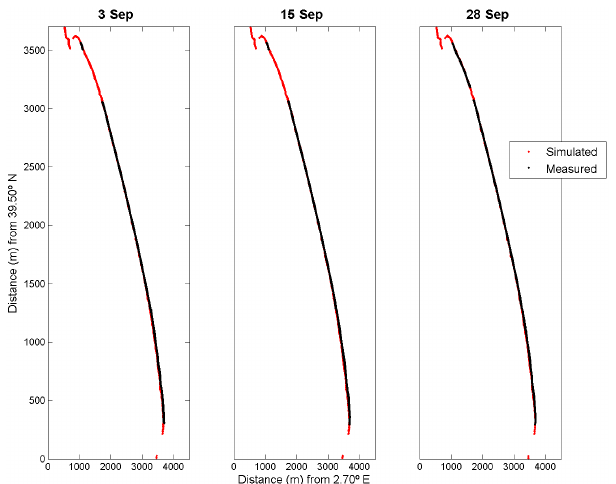
Figure 13. Observed (black) and modelled by SWASH (red) shore- line positions in Playa de Palma.